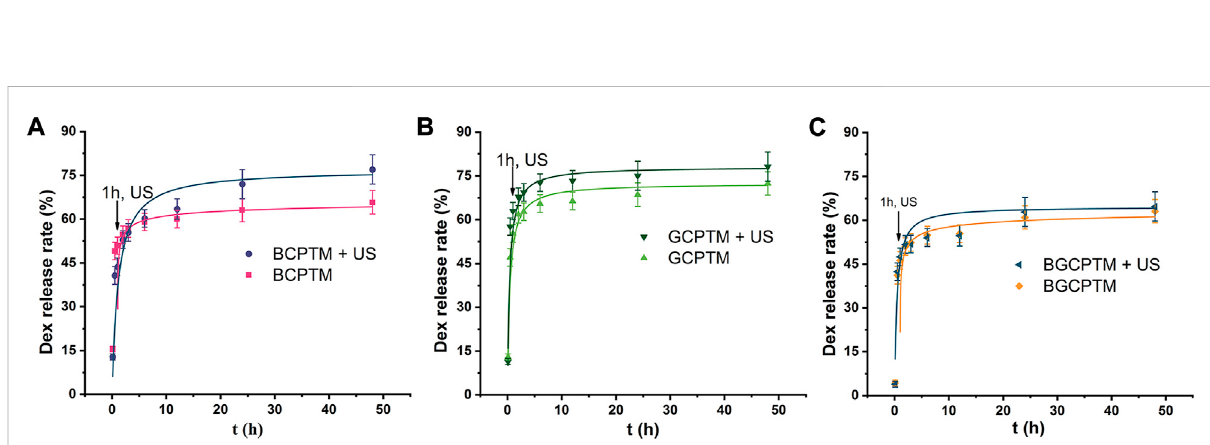
FIGURE 7 In vitro Dex release curve. (A) BCPTM, GCPTM and BGCPTM with and without ultrasound irradiation (1 MHz, 3 W/cm 2 , 20% duty cycle, 3 min at 1 h) at 37 ° C ( n = 3) for 48 h. (B) GCPTM with and without ultrasound irradiation. (C) BGCPTM with and without ultrasound irradiation